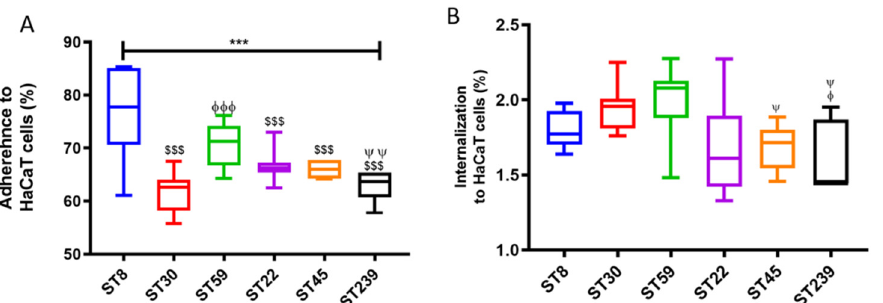
Figure 1. Adherence ( A ) and Internalization ( B ) of six MRSA strains representative of common ST types on HaCaT cells. Error bars represent SD of the mean, and statistical significance was calculated using (*** p -value < 0.001) one-way ANOVA with post hoc Tukey tests. The p -values are coded with respect to each strain and are derived from the comparison between the means of the two respective strains. $$$ ( p < 0.001) shows the p -value of the respective strain when compared to ST8, φ ( p < 0.05), and φφφ ( p < 0.001) show significant difference when compared to ST30. ψ ( p < 0.05) and ψψ ( p < 0.01) depict the significant difference of the respective strain when compared to ST59. The columns with respect to the strains that do not have p -value symbols depict that there is no significant difference between the mean values with respect to each other. The MRSA ST8 was compared against each respective strain; ST30, ST22, ST45 and ST239 revealed p < 0.001 ($$$). For ST30 and ST59, p < 0.001 ( φφφ ), and for ST59 with ST239, p < 0.01 ( ψψ ), respectively. In ( B ), ST59 compared with ST45 and ST239 gave p < 0.05 ( ψ ), and for ST30 compared with ST239, p < 0.05 ( φ ).